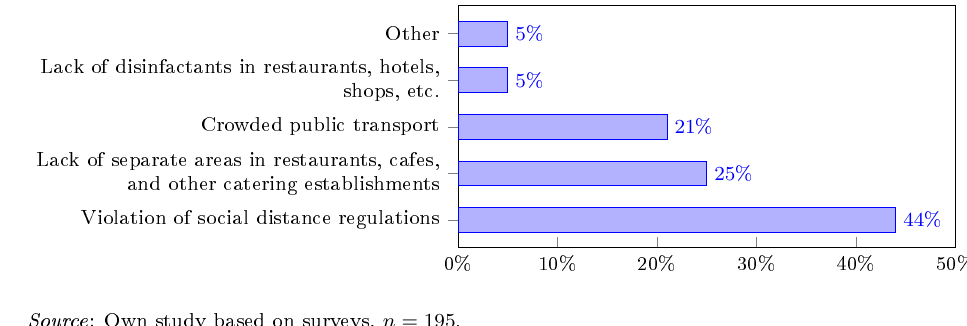
Figure 6: Reasons for negative assessment of urban safety